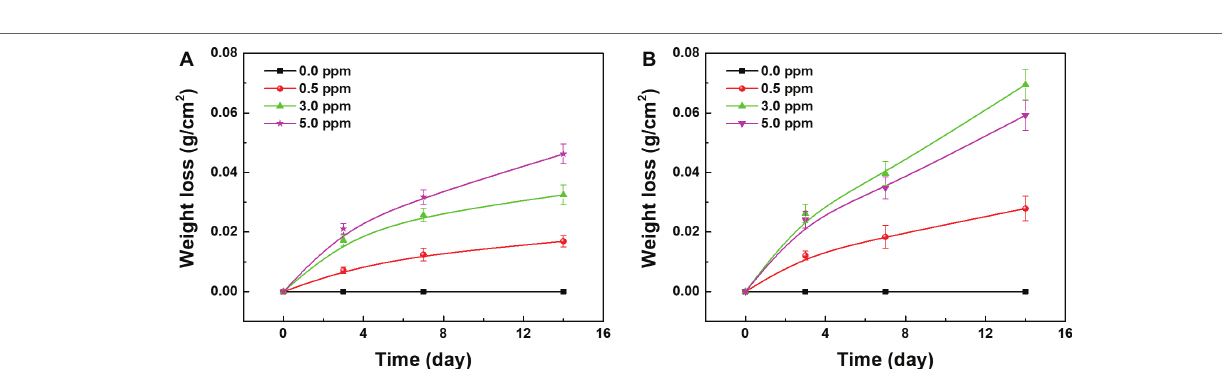
FIGURE 7 | Weight loss of the samples after 3, 7, and 14 days of immersion in (A) sterile media and (B) inoculated media with different DOCs.